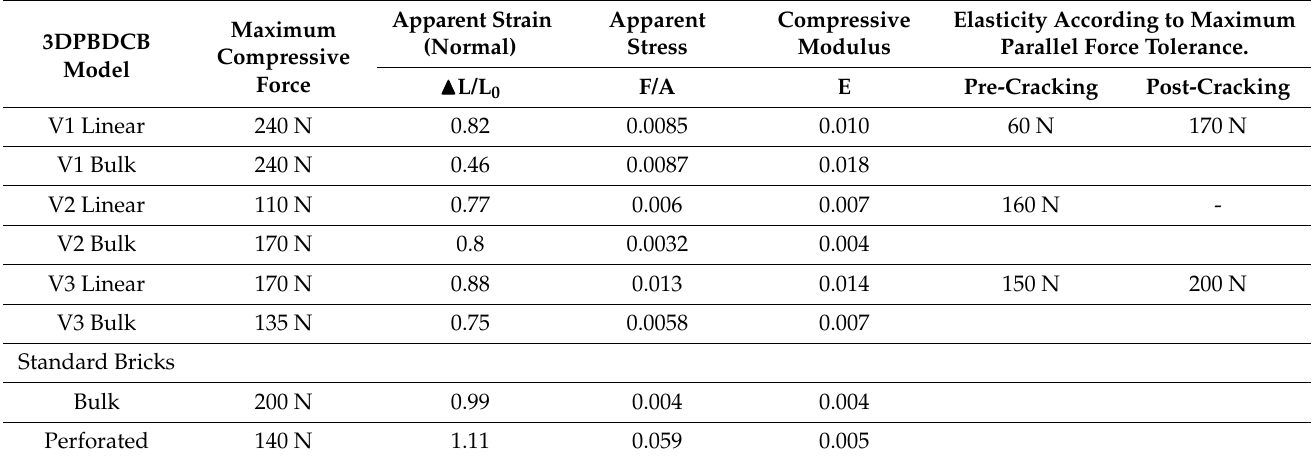
Table 1. Matrix of mechanical properties of the 3DBDCB bricks resulting from the deformation and compression